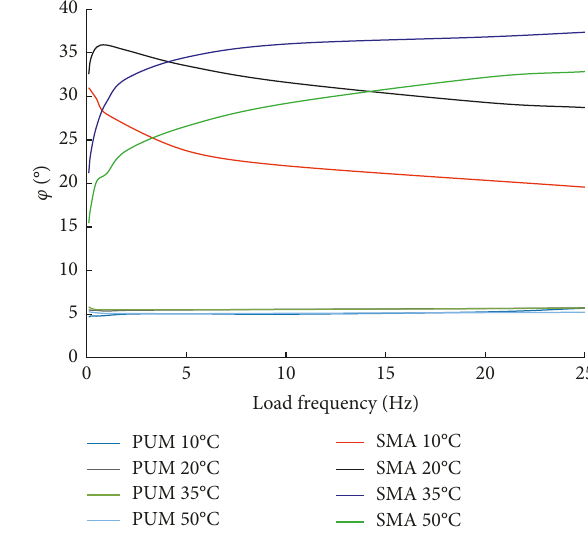
Figure 20: φ of the two mixtures.